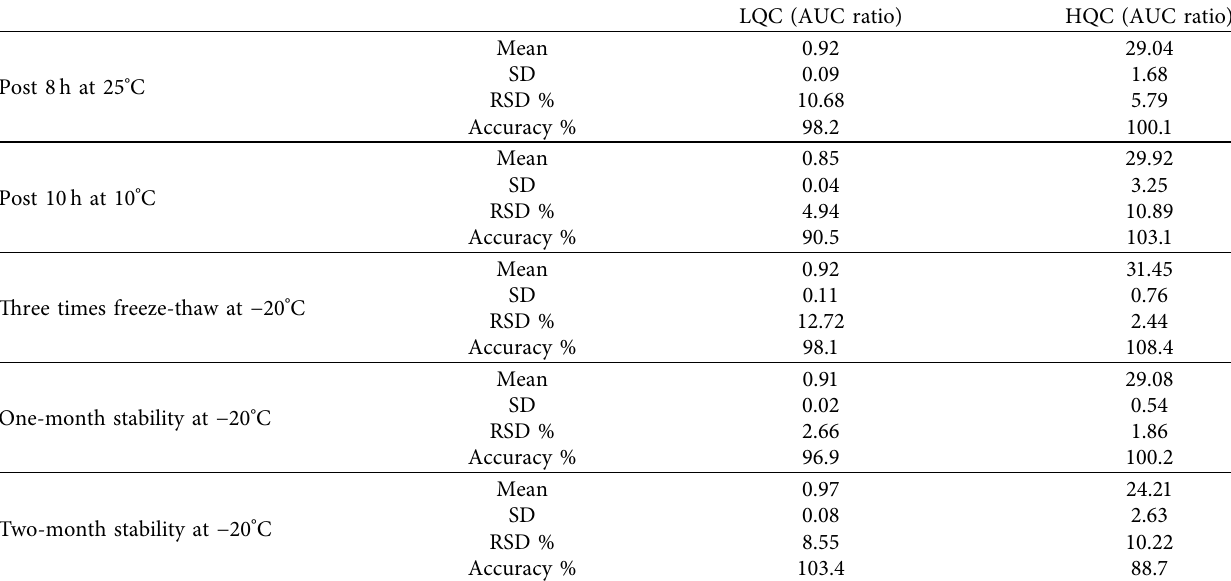
Table 3: Stability test of vardenafil in plasma.